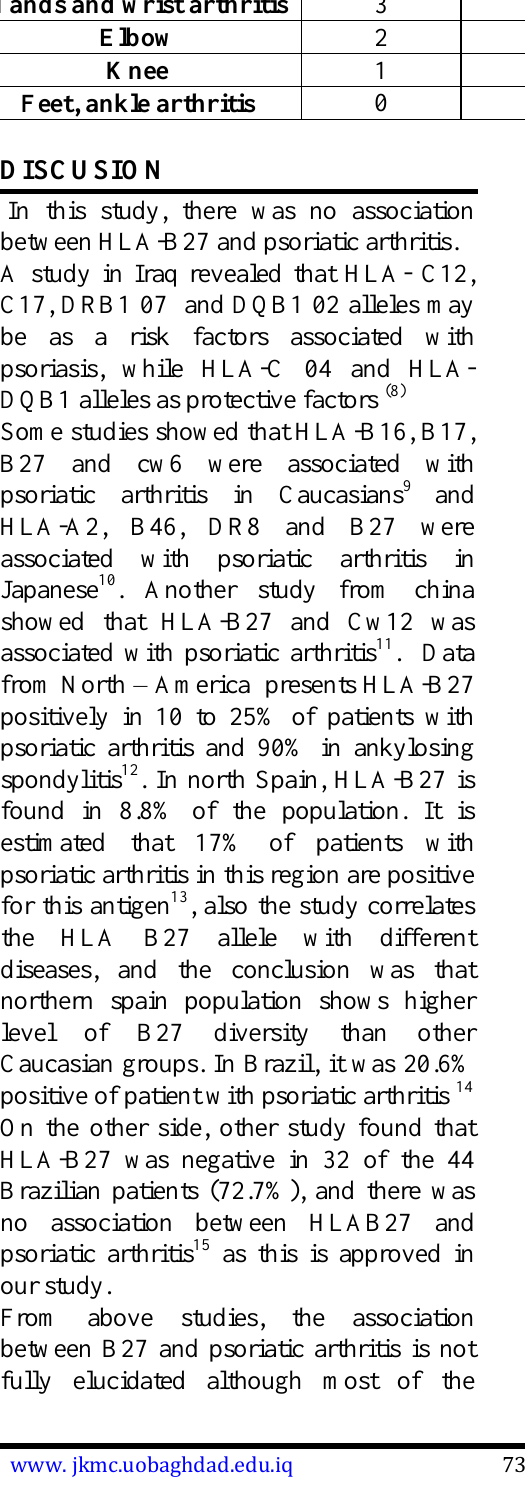
Hands and wrist